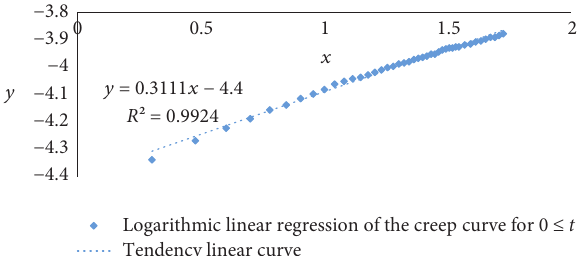
Figure 14: The curve of mean compressive failure stresses as a function of diameter in radial direction.